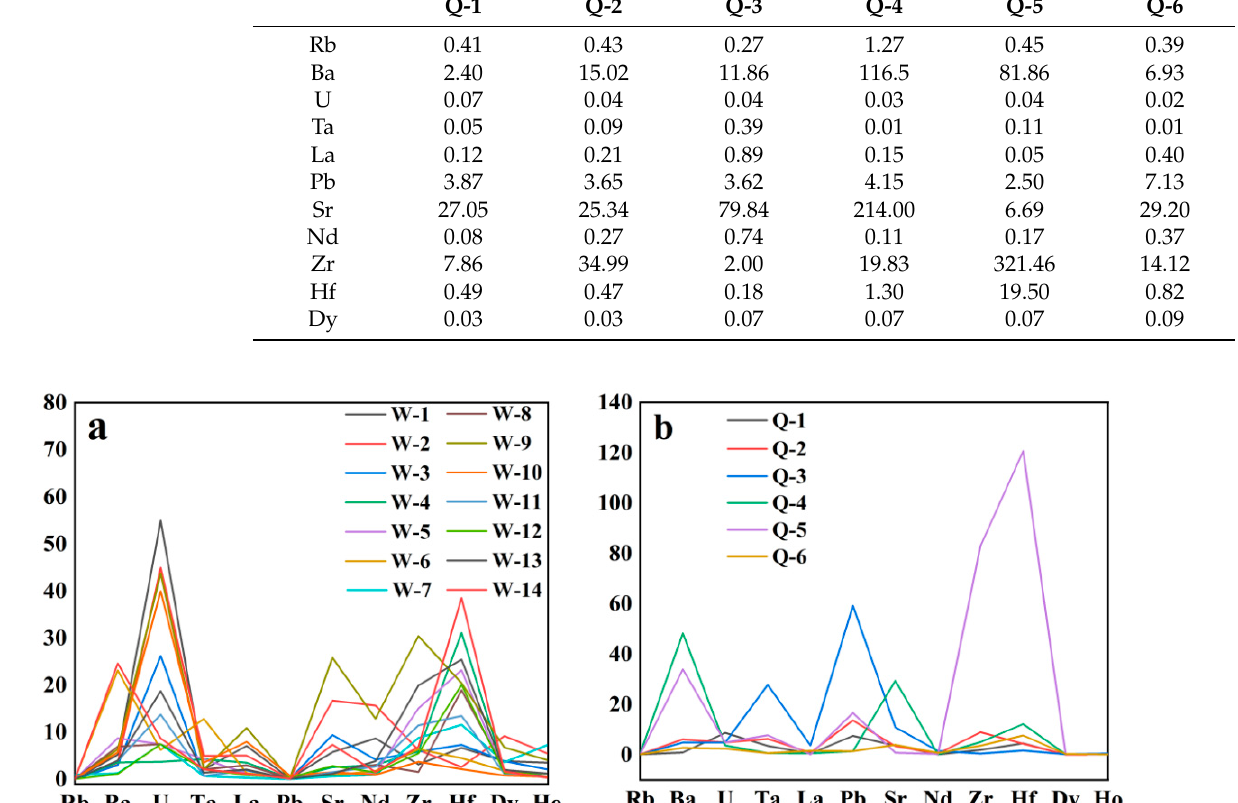
Figure 3. Map of standard levels of trace elements in Guatemalan and Qing dynasty jadeite. ( a ) is Guatemalan jadeite and ( b ) is Qing dynasty jadeite